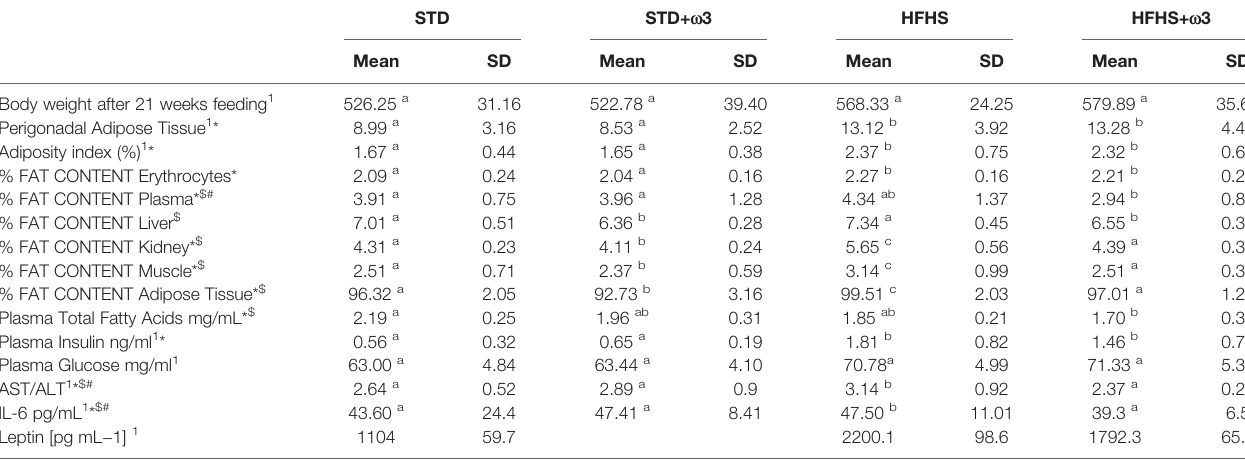
TABLE 1 | Morphological values, lipid content, insulin resistance and in fl ammatory parameters from Sprague-Dawley rats with different diets. STD STD+ w 3 HFHS HFHS+ w 3